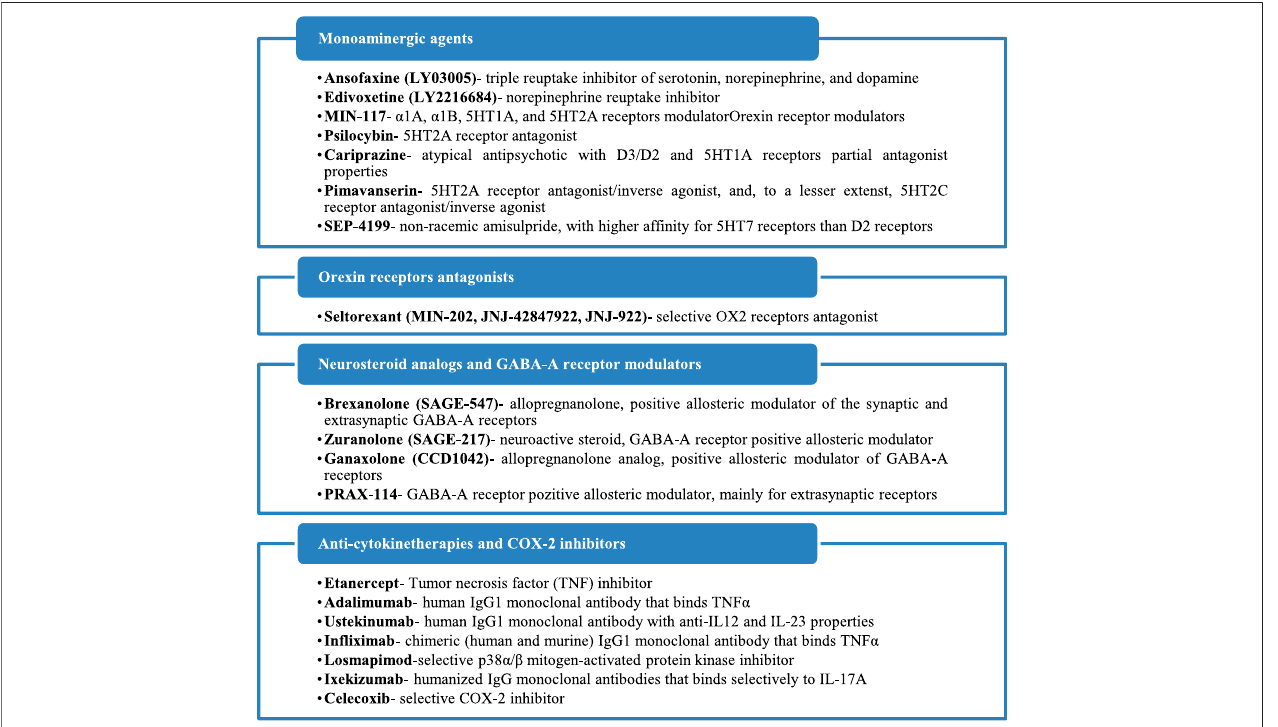
FIGURE 2 | Mechanisms of action of the identi fi ed antidepressants in the pipeline, which are presented in this review.